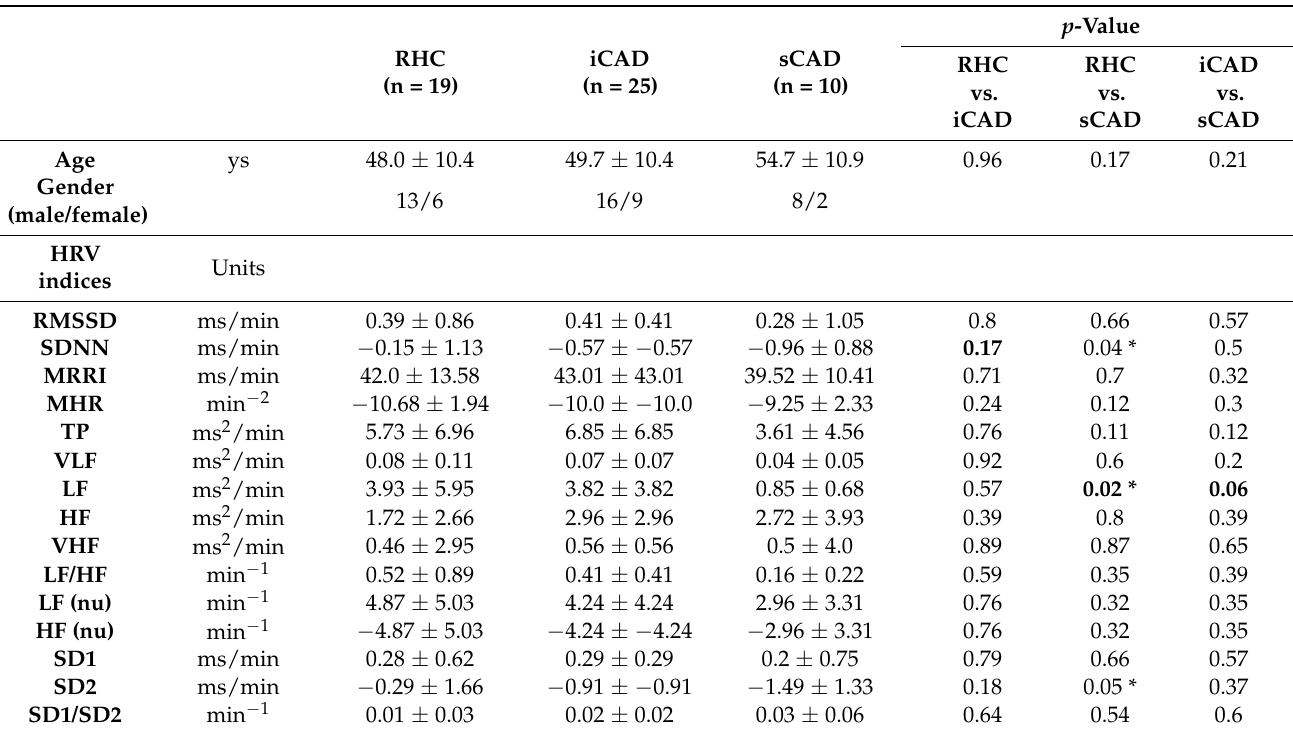
Table 3. Population characteristics and the recovery slope (means ± standard deviation) of each HRV index with a p value between any two groups during the recovery phase. Bold highlights the best performances. The symbol * indicates a significant difference at the 0.05 level ( p <